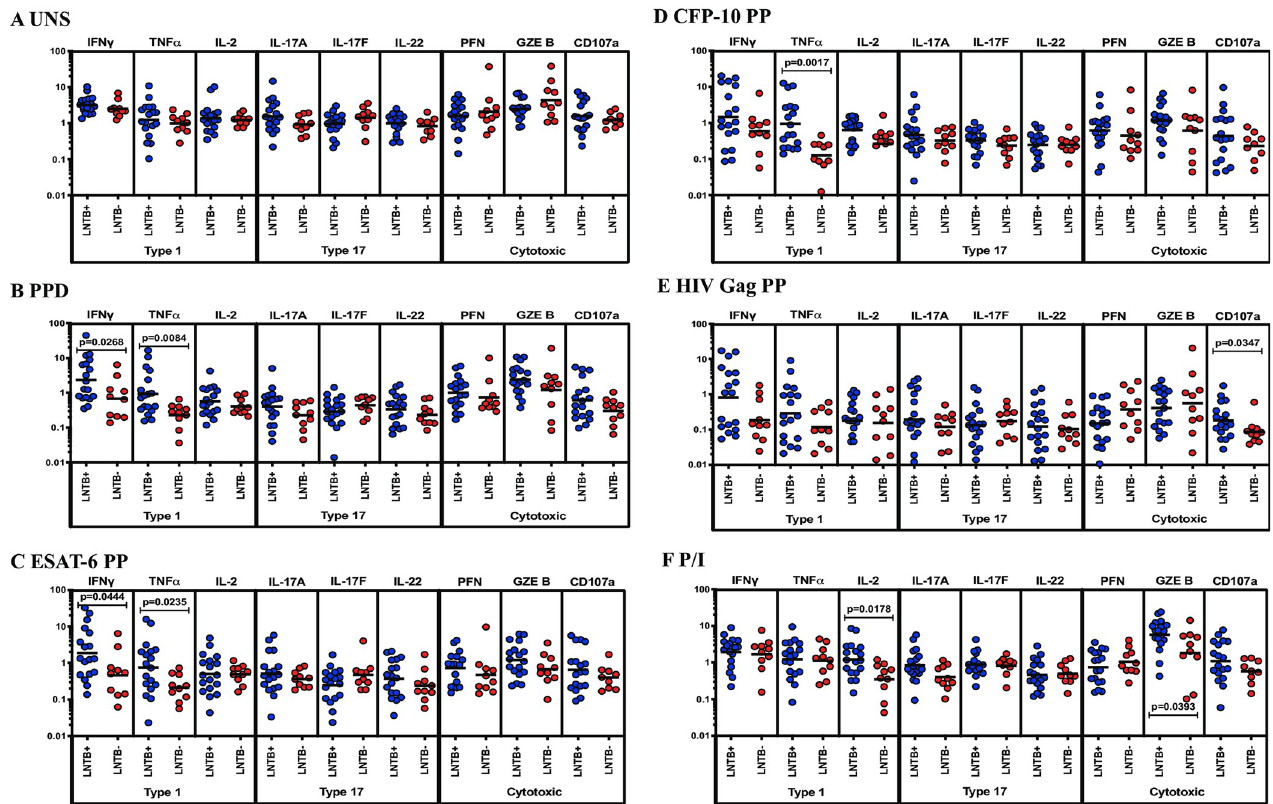
Fig 3. LNTB+ individuals are associated with enhanced antigen-induced frequencies of NK cells expressing type 1 (IFN γ , TNF α ) cytokines. LN cells from LNTB+ (n = 18) and LNTB- (n = 10) individuals were either unstimulated (UNS) or stimulated with mycobacterial (PPD, ESAT-6 PP, CFP-10 PP), HIV Gag PP and positive (P/I) control antigens for 18 hours. LN cells were harvested, stained and analyzed using multicolour flow cytometry. (A) UNS (B-D) Mtb antigen (E) HIV Gag PP and (F) P/I antigen-stimulated CD4 + T cell expressing frequencies of type 1 (IFN γ , TNF α , IL-2), type 17 (IL-17A, IL-17F, IL-22) cytokines and cytotoxic (PFN, GZE B, CD107a) markers were illustrated. Geometric mean was shown using a bar and Mann-Whitney U test was performed to calculate the p values and p < 0.05 is denoted as statistically significant. For each individual, we have given the values as net frequencies and they were obtained by deducting the unstimulated frequencies from the antigen-stimulated